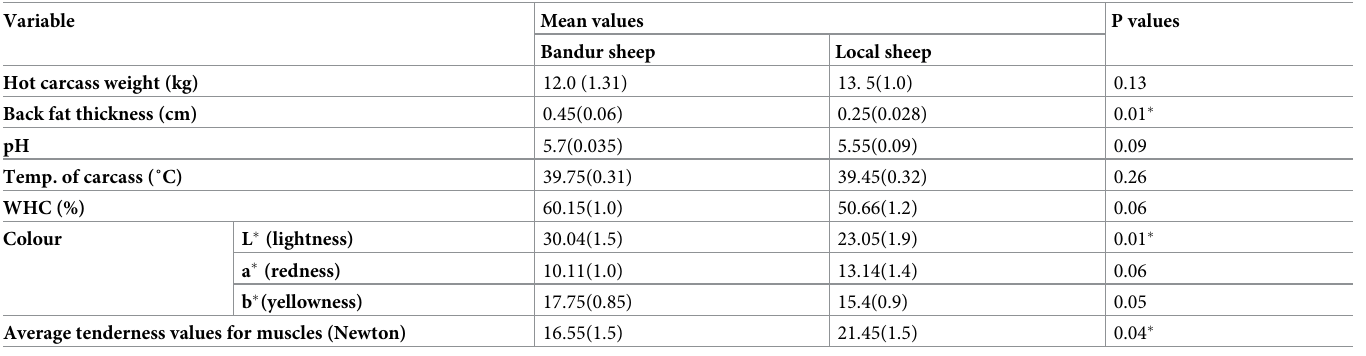
Table 1. Comparison of carcass and meat quality traits of Bandur and local sheep of Karnataka.